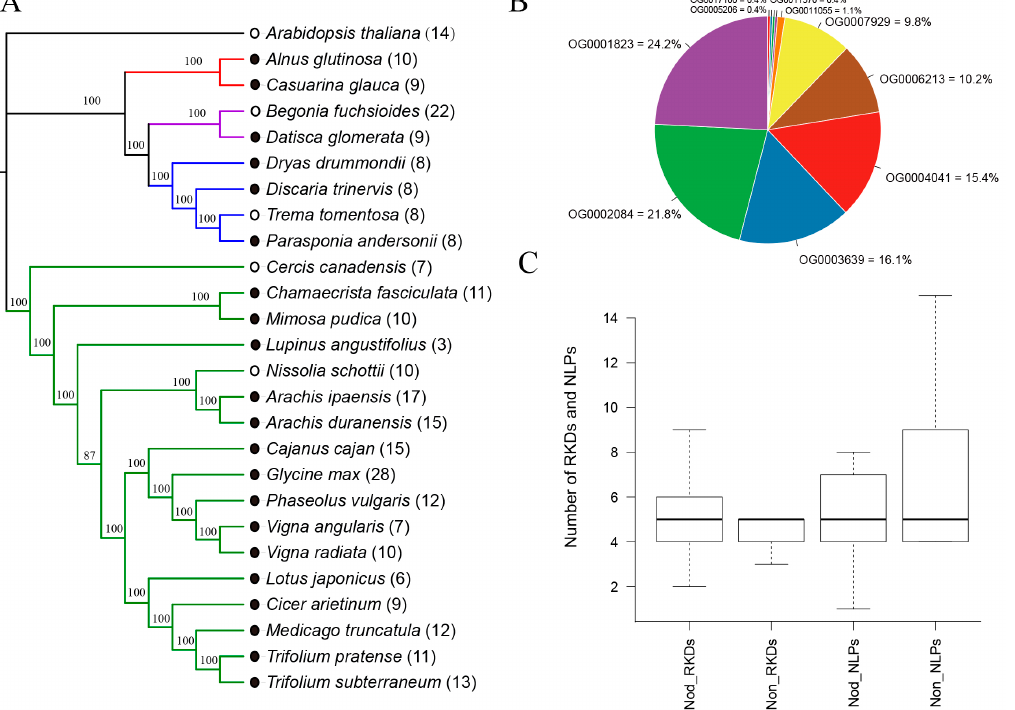
Figure 1. Origin and distribution of RWP-RKs in nitrogen-fixing clade (NFC). ( A ) Phylogeny of NFC species based on gene duplication events constructed using the maximum-likelihood method. The numbers on branches represent bootstrap values, and the numbers in round brackets represent the number of RWP-RK family members. The nodulating plants are indicated by filled circles, and the non-nodulating plants are indicated by empty circles. Each color line represents different orders of NFC, Fagales with red, Cucurbitales with purple, Rosales with blue, and Fabales with green. ( B ) Origins of RWP-RKs, as indicated by the distributions of different orthogroups. ( C ) Distribution of RWP-RK-domain proteins (RKDs) and nodule inception (NIN)-like proteins (NLPs) between nodulating plants (Nod) and non-nodulating plants (Non).